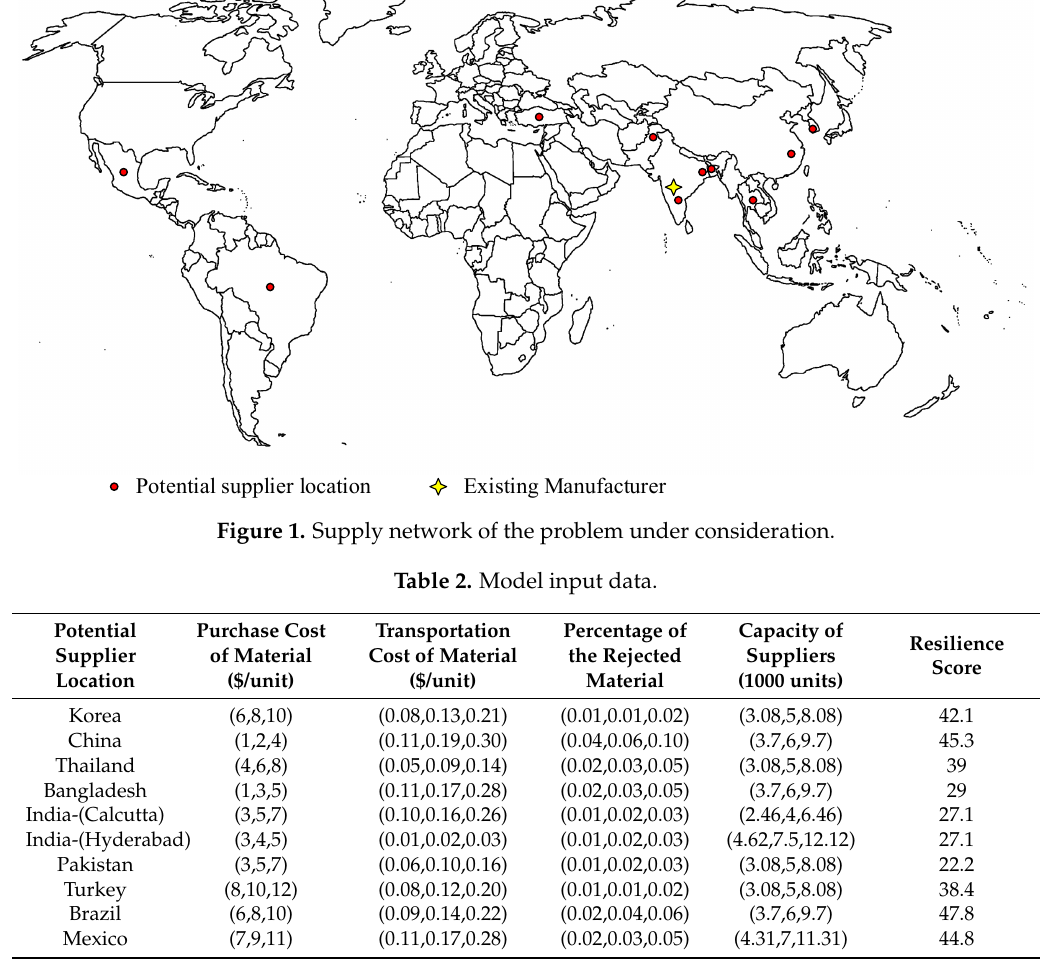
Table 3. Transit time from suppliers.